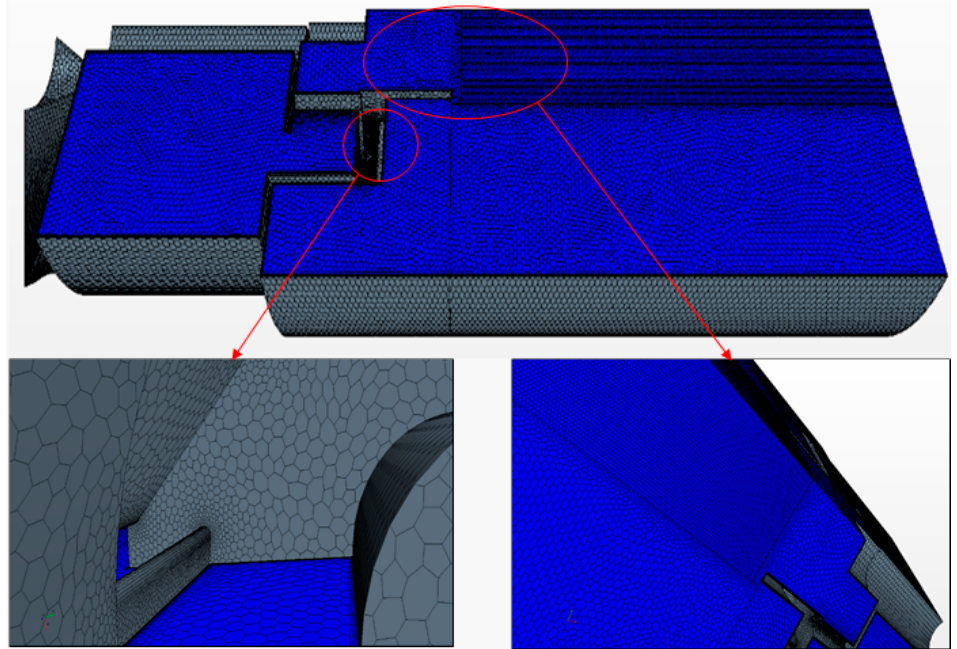
Figure 2. Mesh used for modelling. ( Top ) Full mesh; ( Bottom left ) Details of the swirl vanes; ( Bottom right ) Close-up of local mesh refinement.